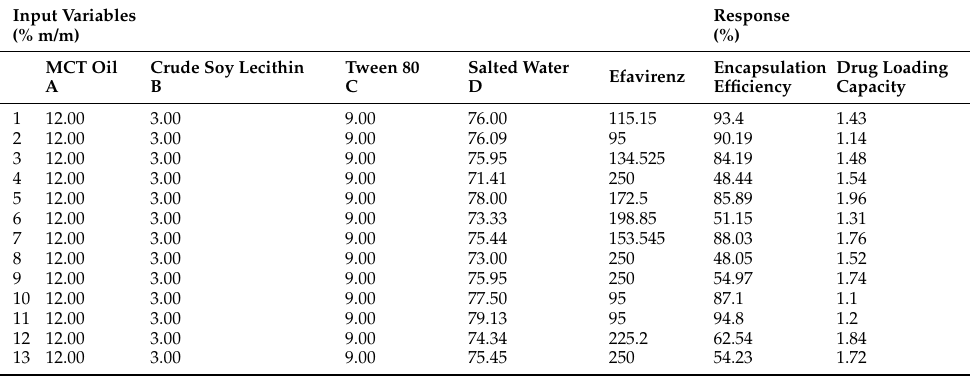
Table 9. Encapsulation efficacy and drug loading capacity of blend 1.